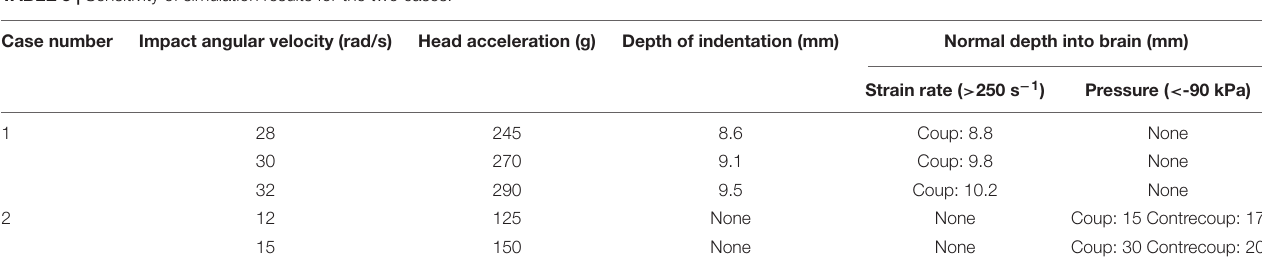
FIGURE 9 | Correspondence between ADC values from clinical data and simulated minimum pressure for case 2. ADC (A) and minimum pressure (C) contours are shown for the coup–contrecoup plane; ADC (B) and minimum pressure (D) plot along the coup–contrecoup (C-CC) line with the points 1, 2, and 3 (inside ventricles) marked in (A) . The dotted line represented approximate mean value of ADC in (B) . Minimum pressure shown in cerebrum, cerebellum, and brainstem only. TABLE 5 | Sensitivity of simulation results for the two